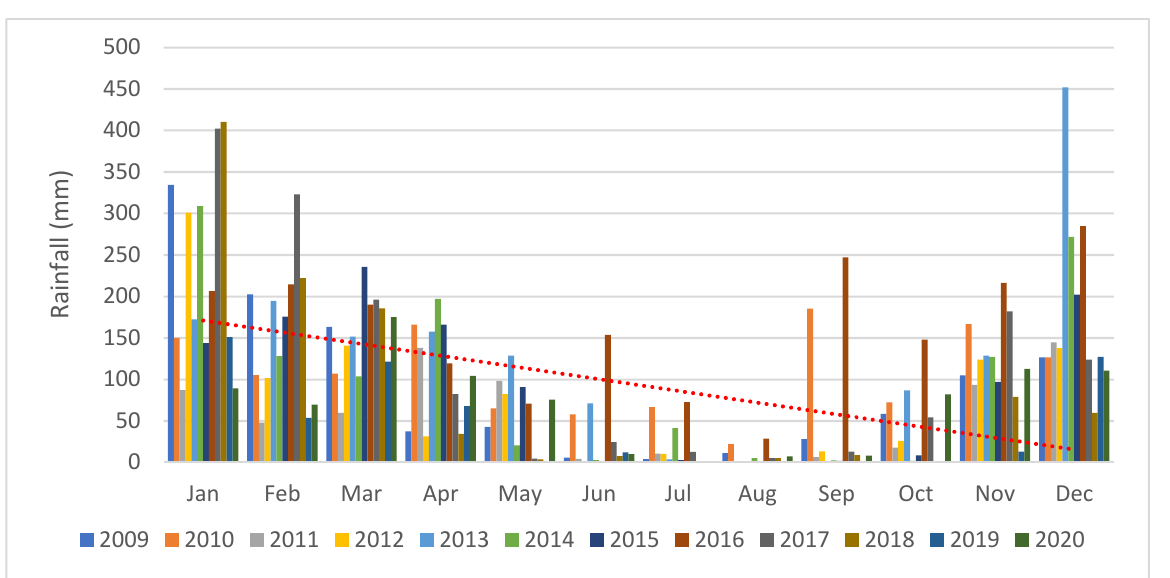
Figure 6. Rainfall pattern in the Dodokan watershed from 2009–2020. The correlation between rainfall and drought index shows that rainfall significantly affects the drought index. The relationship between the two is expressed by the equation Y = − 0.155x − 0.499, with a standard error of 0.023. The trend of the monthly drought index in 2009–2020 shows an increase (Figure 7).